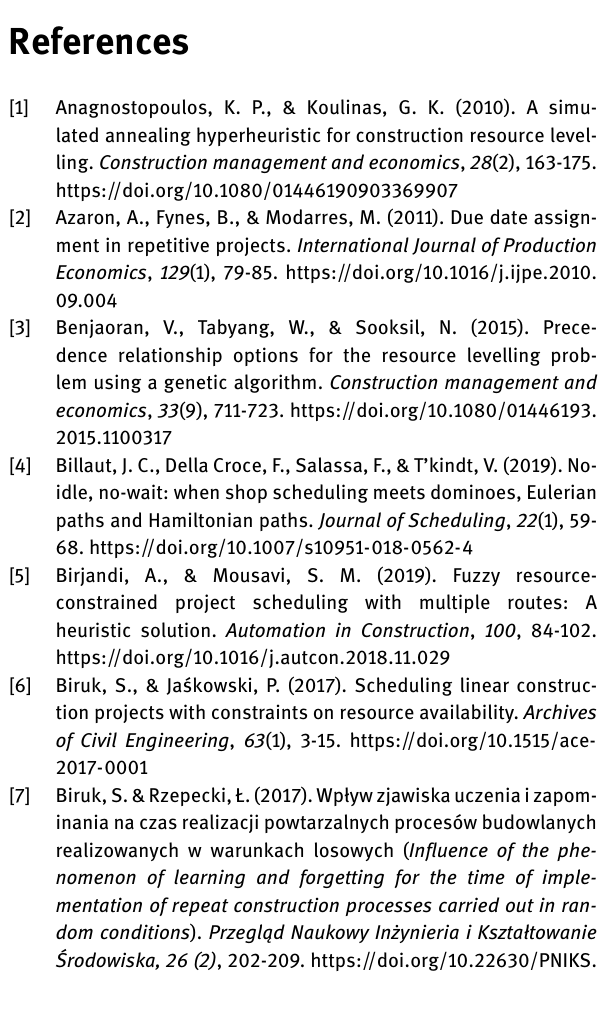
Figure 2: The schedule of employment of crews in solving the com- promise optimization